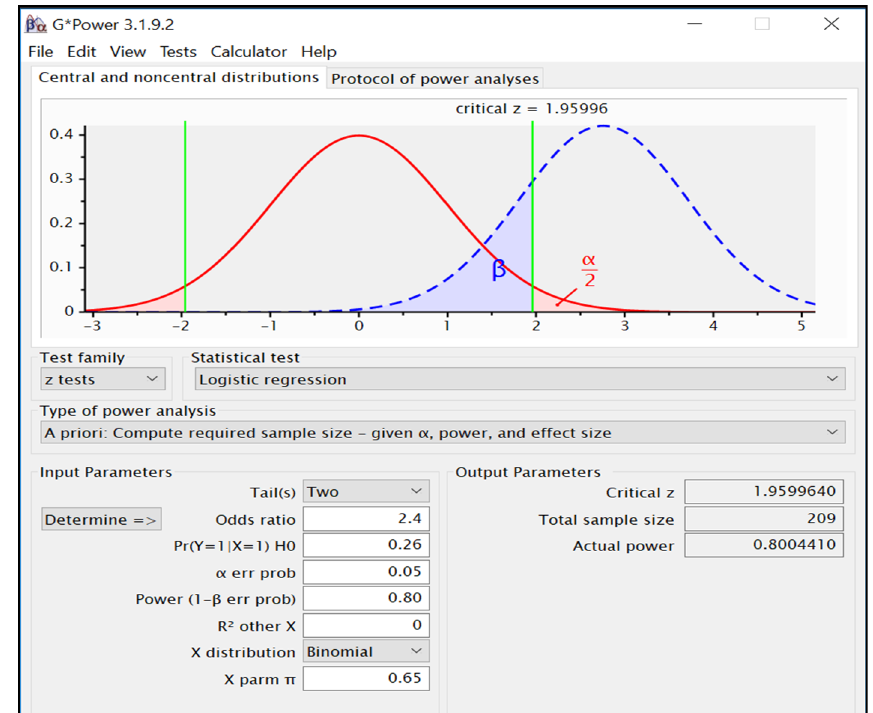
Figure A1. G* power sample size output.